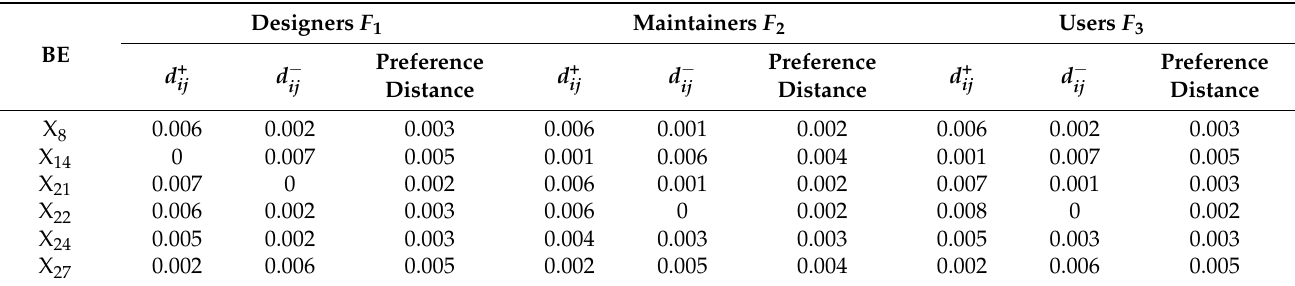
Table 11. The preference